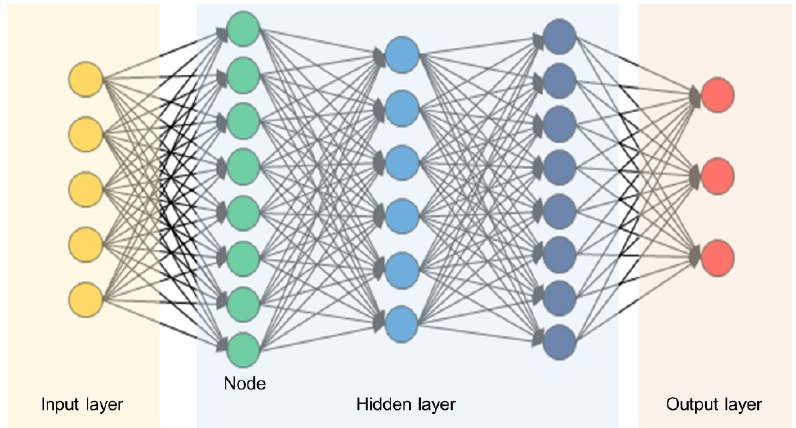
Figure 6. Conceptual diagram of a deep neural network (DNN). Circles represent nodes in each layer.